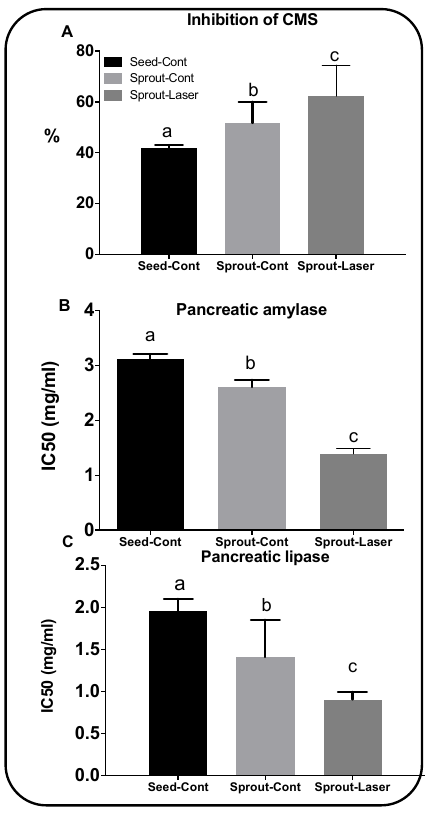
Figure 2. Effect of He-Ne laser light treatment on the anti-cholesterol activity of Cymbopogon proximus sprouts and seeds. ( A ) inhibition of CMS (cholesterol micellar solubility); ( B ) Pancreatic amylase; ( C ) Pancreatic lipase. Data are represented by means ± standard errors. Different small letters (a, b, c) above bars indicate significant differences between means at p ≤ 0.05.